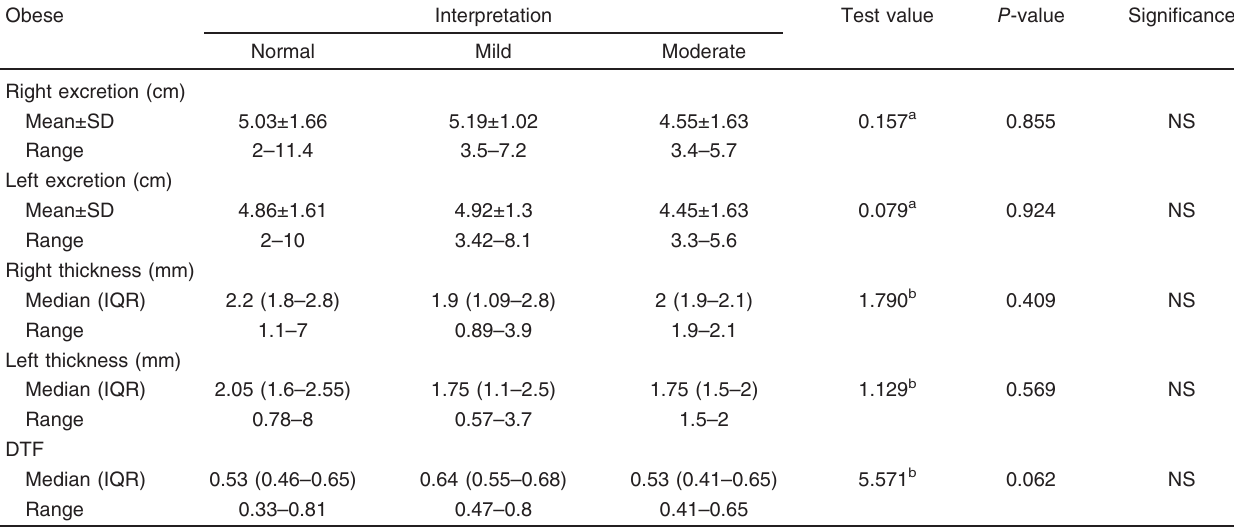
Table 4 Relation between degree of restrictive pattern and sonographic diaphragmatic indices in obese persons